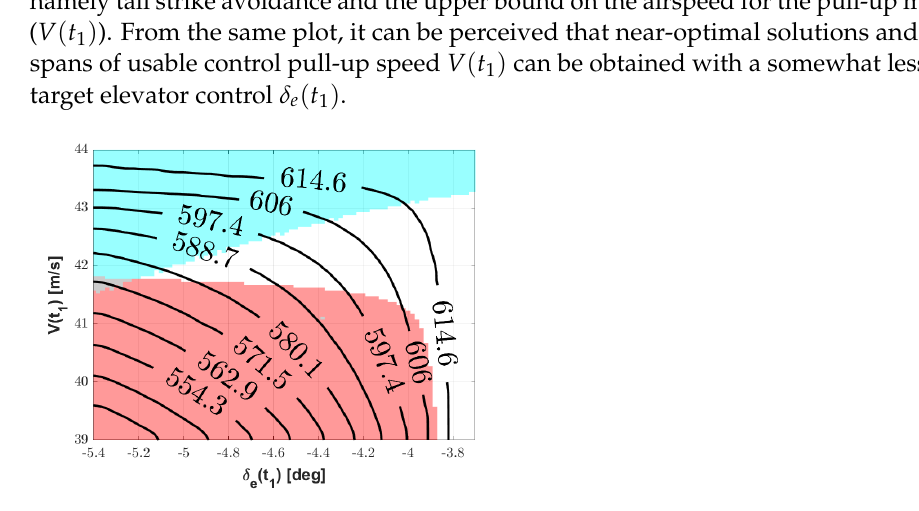
Figure 7. Three-dimensional representation of D TO in the vicinity of the optimal solution. Red area: tail strike. Cyan area: take-off before control pull-up. Grey area: two or more constraints